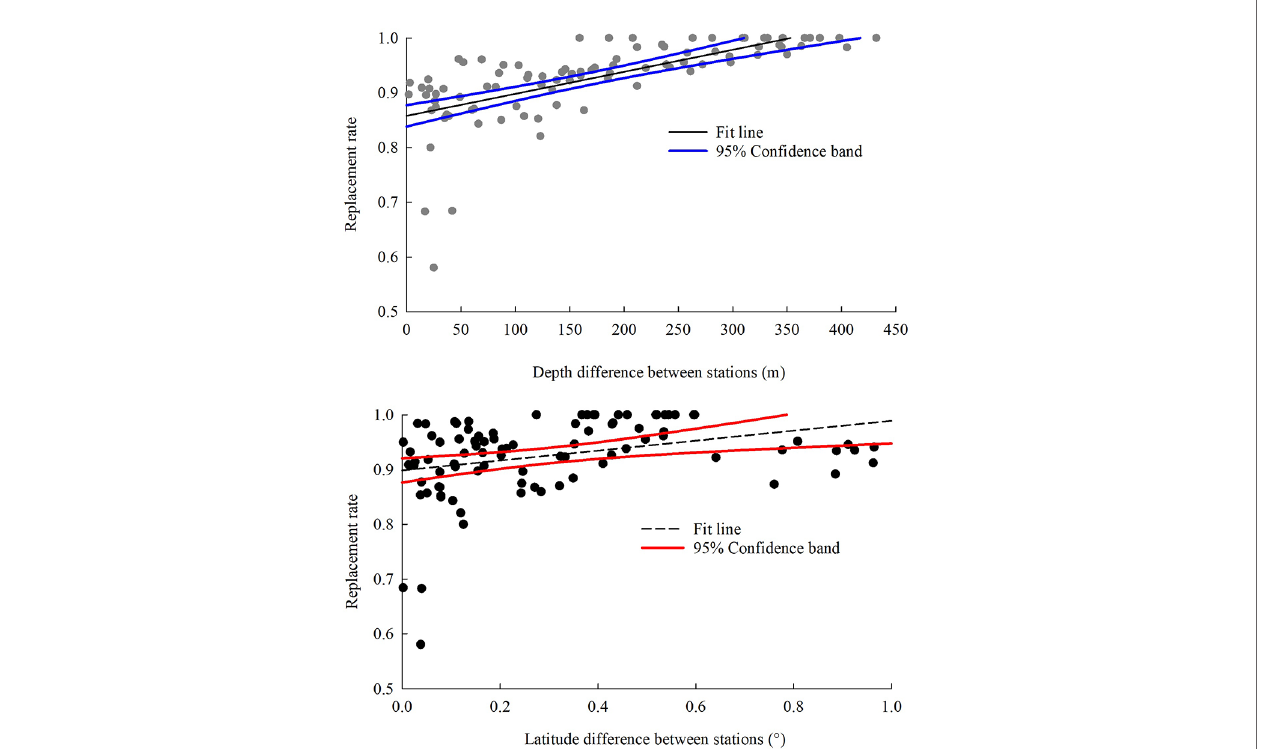
FIGURE 4 | Depth and latitude-related trends in replacement rate of demersal fi sh species over the